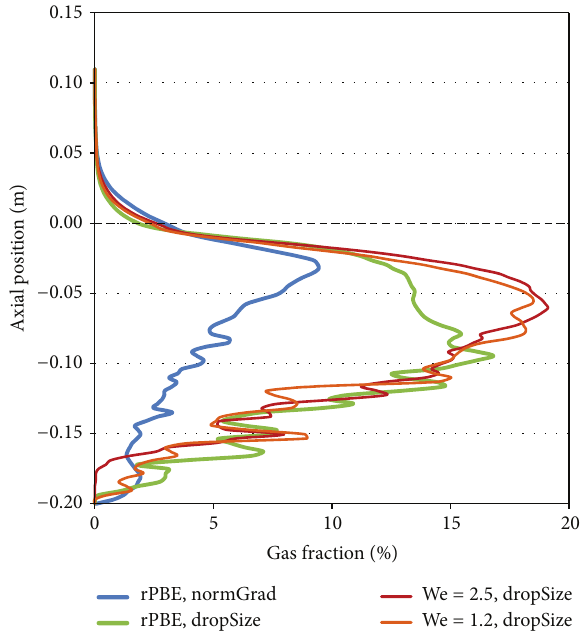
Figure 11: Gas fraction along the vertical line on the jet axis for each of the four